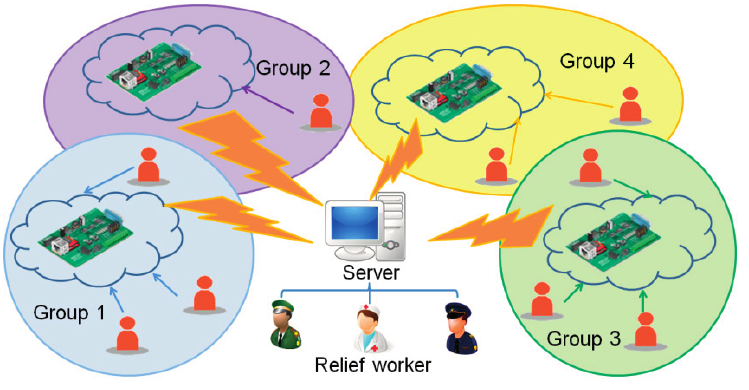
Figure 7. Usage scenario of emergency message board.